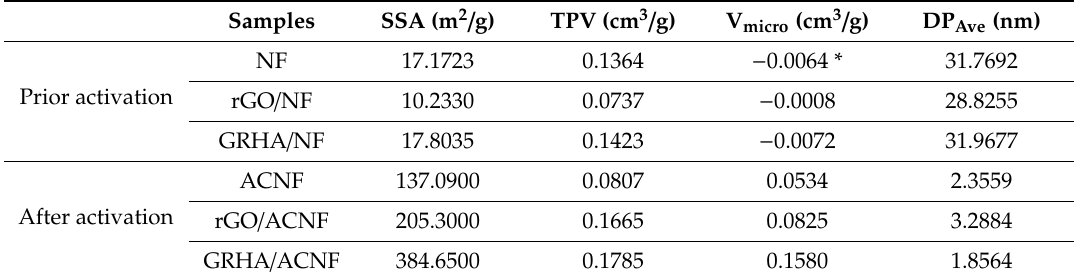
Table 2. Porous structure characteristics of pristine and composite activated carbon nanofibers s prior to and after activation. Samples SSA (m 2 / g) TPV (cm 3 / g) DP Ave (nm)